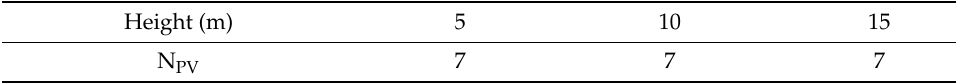
Table 12. Results of scenarios 1 and 2.